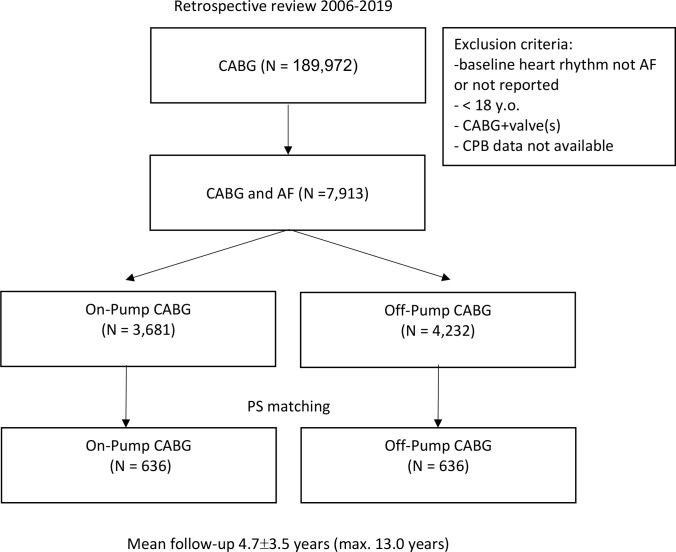
Flow diagram of the current study cohort undergoing On-Pump and Off-Pump CABG surgery in concomitant atrial fibrillation.AF, atrial fibrillation; CABG, coronary artery bypass grafting; PS, propensity score.